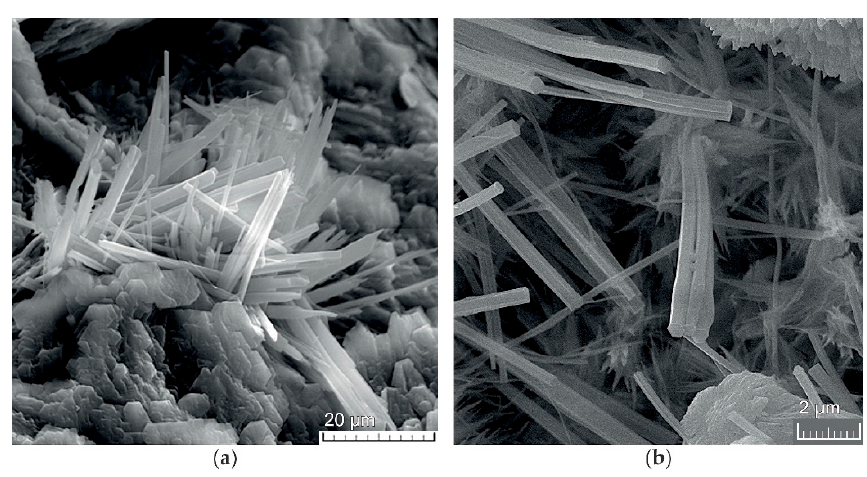
Figure 1. ( a ) Crystals of ettringite [14], ( b ) crystals of thaumasite.